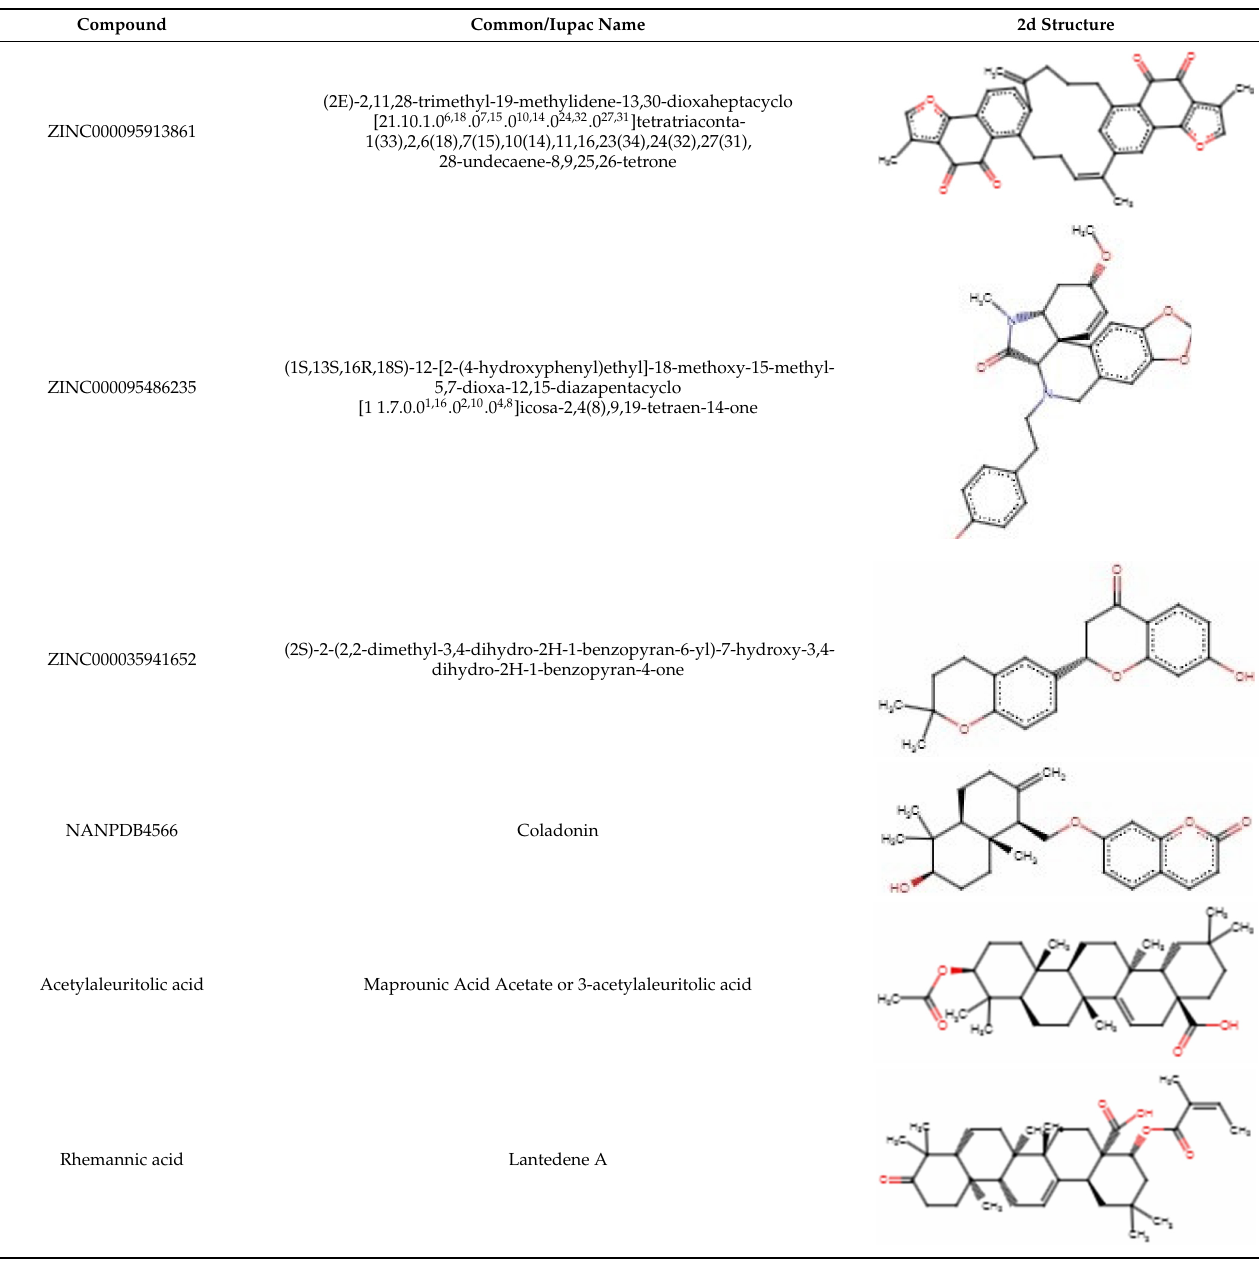
Table 5. A list of the selected compounds with their 2D structures and common/IUPAC names. The UPAC names were generated using MarvinSketch (ChemAxon Ltd., MarvinSketch version 17.17.0, Budapest,